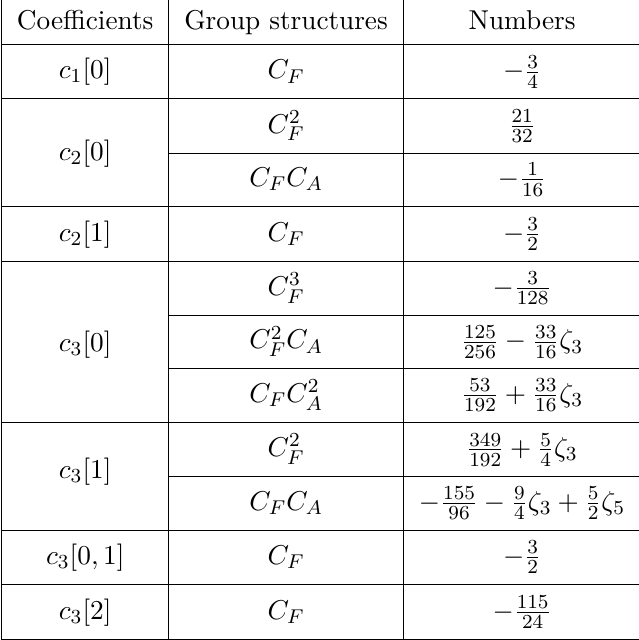
Table 4 . All terms included in the { β } -expansion of coefficients c 1 , c 2 and c 3